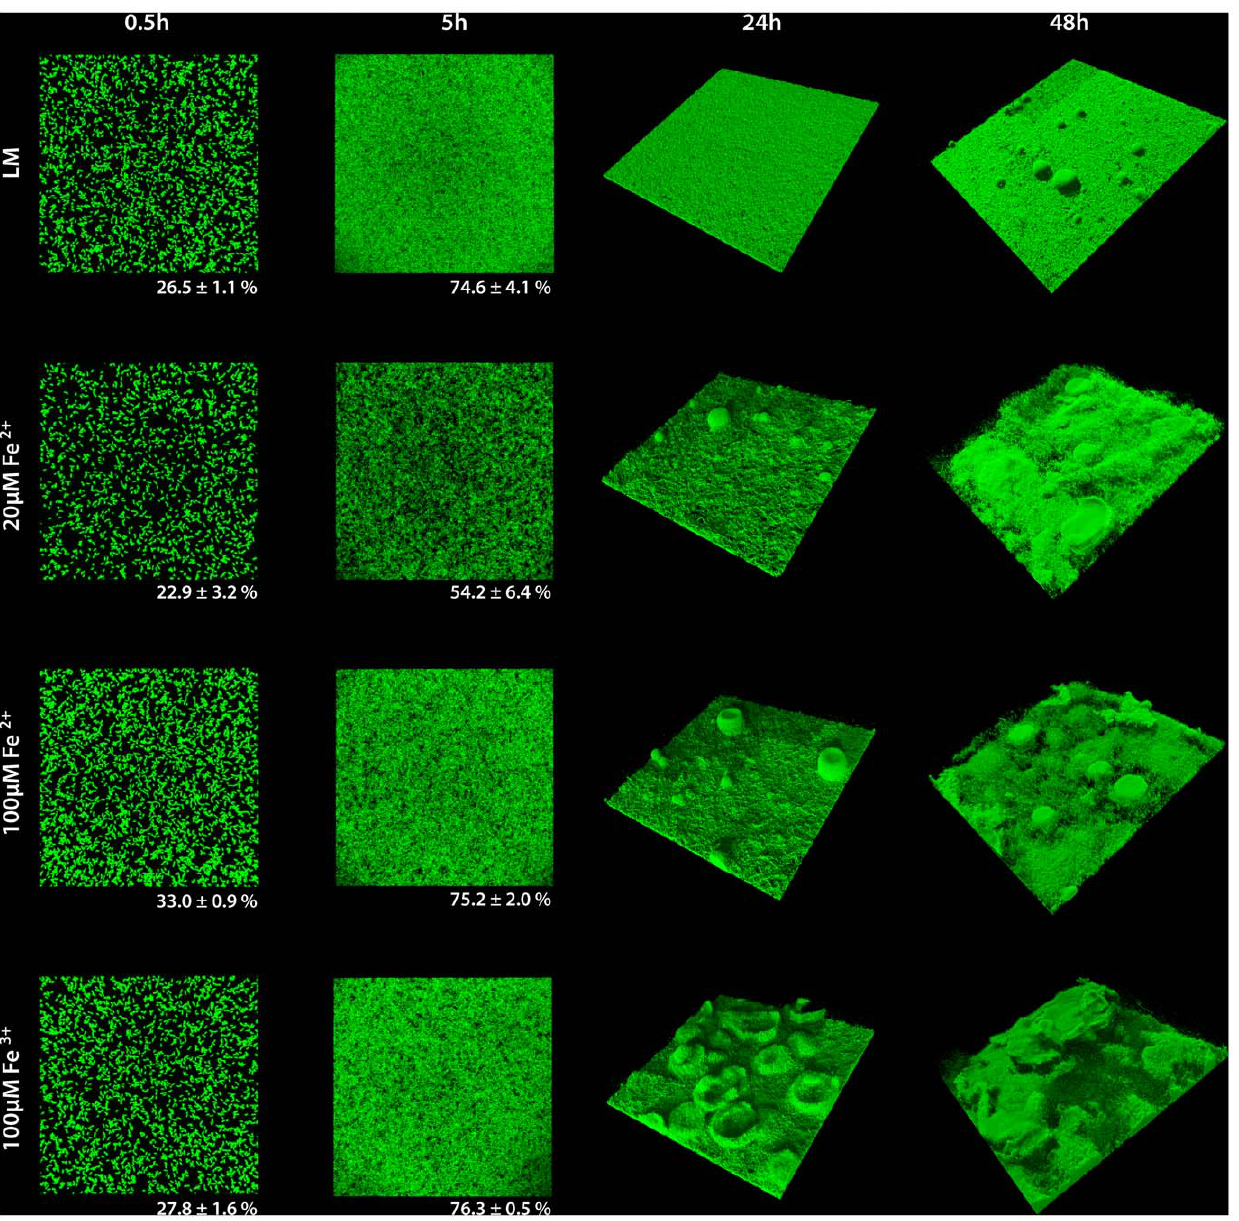
Figure 3. Influence of iron addition to S.oneidensis MR-1 biofilm formation under hydrodynamic conditions. Gfp-tagged S. oneidensis MR-1 wild-type cells were incubated in flow chambers in LM medium (upper panel) that was supplemented with iron at the indicated concentrations (lower panels). Biofilm formation was analyzed by CLSM at the indicated time points, displayed are three-dimensional shadow projections. The numbers below the images recorded after 0.5 and 5 hours represent the average surface coverage. The lateral edge of each image is 250 m m in length.